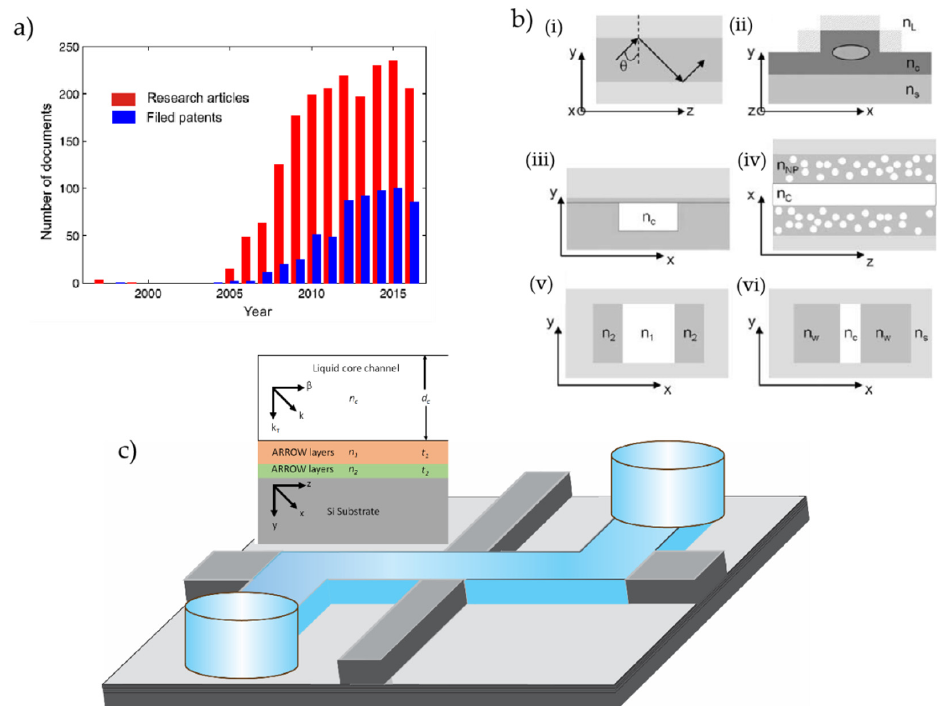
Figure 2. ( a ) The numbers of published research articles and filed patents in chronological order in the domain of optofuidics (data retrieved from Scopus on 26 May 2017) [119]. ( b ) Total internal reflection (TIR)-based waveguides [121]. ( i ) TIR principle in slab waveguide, ( ii ) cross section of solid core ridge waveguide with mode area (ellipse) and penetration area into surrounding liquid (hatched areas); ( iii ) liquid-core waveguide (LCW) cross section, ( iv ) nanoporous cladding waveguide (side view), ( v ) liquid–liquid core (L 2 ) waveguide (cross section); ( vi ) slot waveguide (cross section). ( c ) Schematic representation of a typical ARROW optofluidic device with the wave vectors (( c ) is used upon permission from the Applied Optics group at the University of California, Santa Cruz, CA,